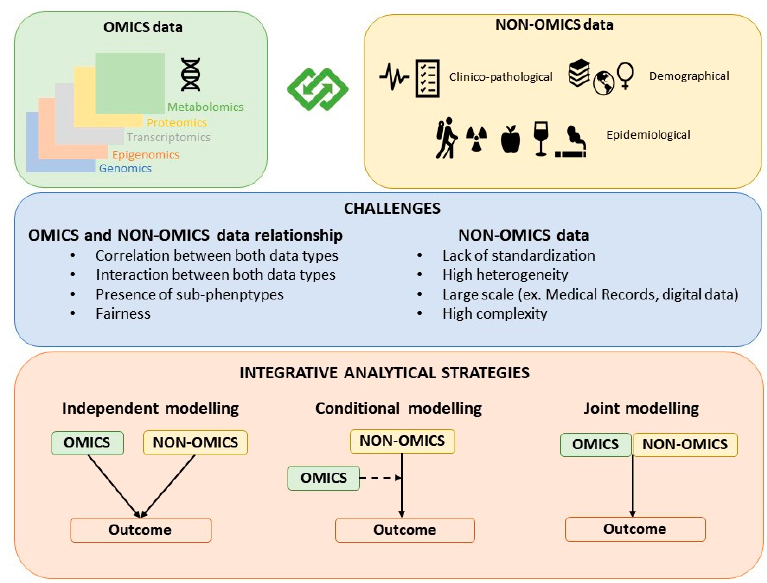
Figure 1. Classification of the strategies for building OnO models .